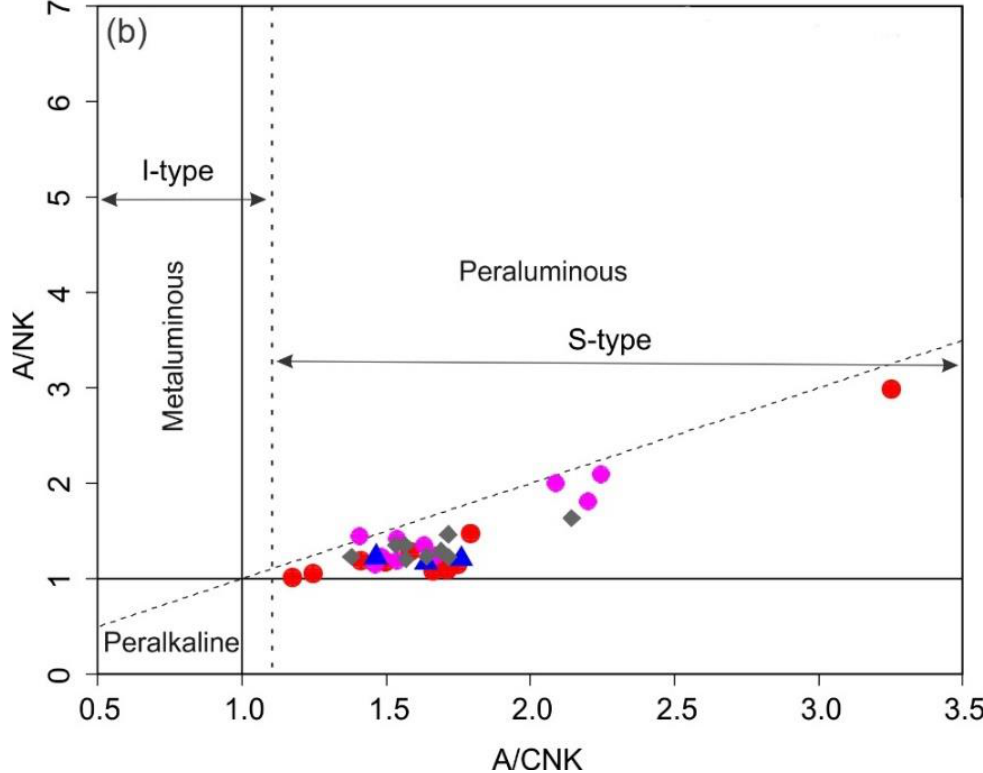
Figure 5. Plots of ( a ) total alkali (Na 2 O + K 2 O) vs. SiO 2 after [35]. Due to bulk samples being taken from the alkali feldspar-rich zones of the Yamrang Pegmatite, some data plot in the syenite field. ( b ) A/NK vs. A/CNK after [36] of pegmatites and granites from the Higher Himalaya of Eastern Nepal.